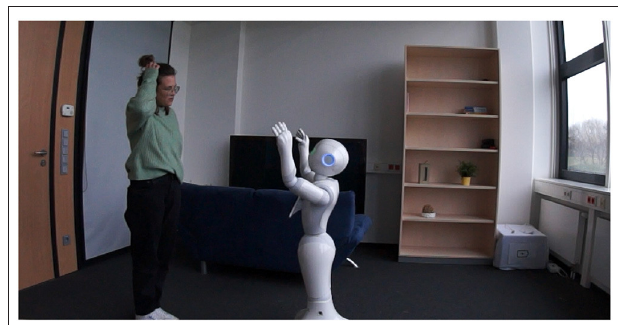
FIGURE 1 | Interaction situation in which a puzzled user is looking for a behavior explanation by the robot.